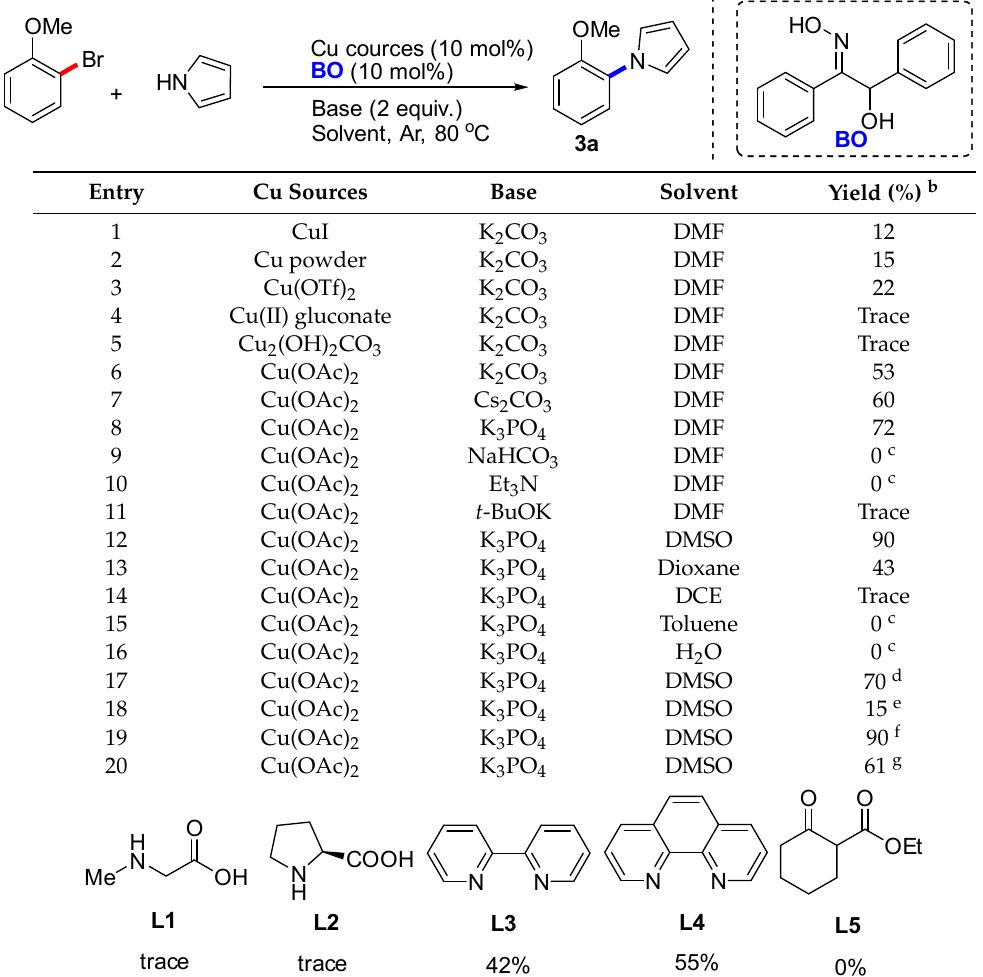
Table 1. Identification of reaction condition a .